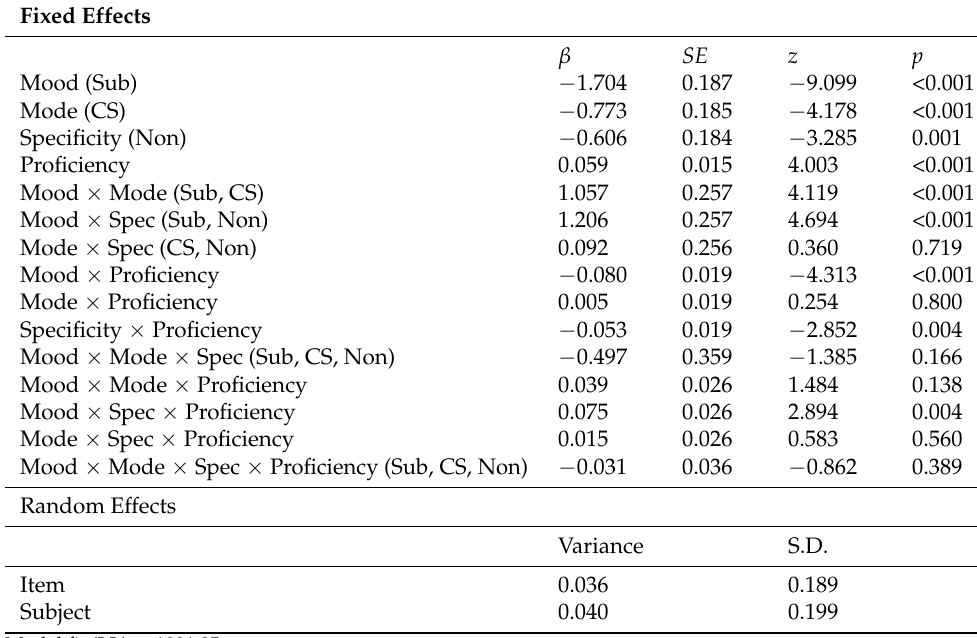
Table 3. Final model of speaker ratings, with proficiency (reference level is Spanish-only, Indicative mood, Specific antecedents, proficiency centered at